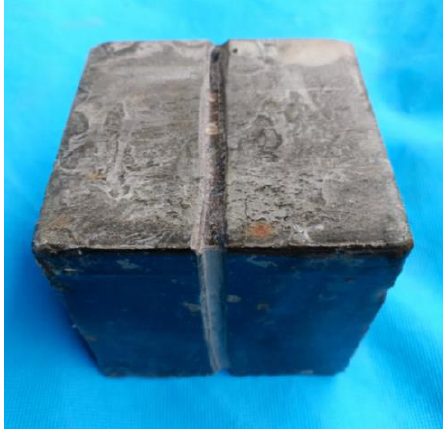
Figure 5. Pretreatment of split specimen.